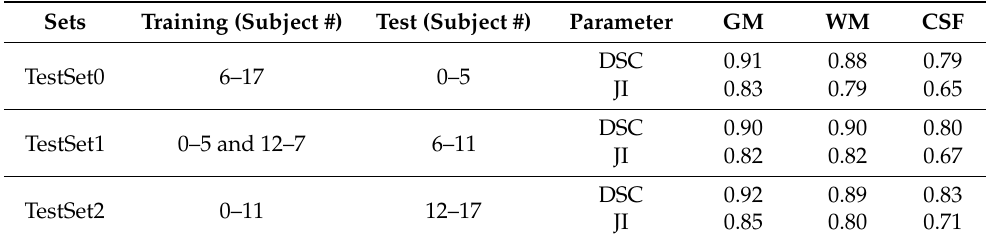
Table 7. Segmentation results obtained using the cross-validation approach, which randomly selects MRIs of the IBSR